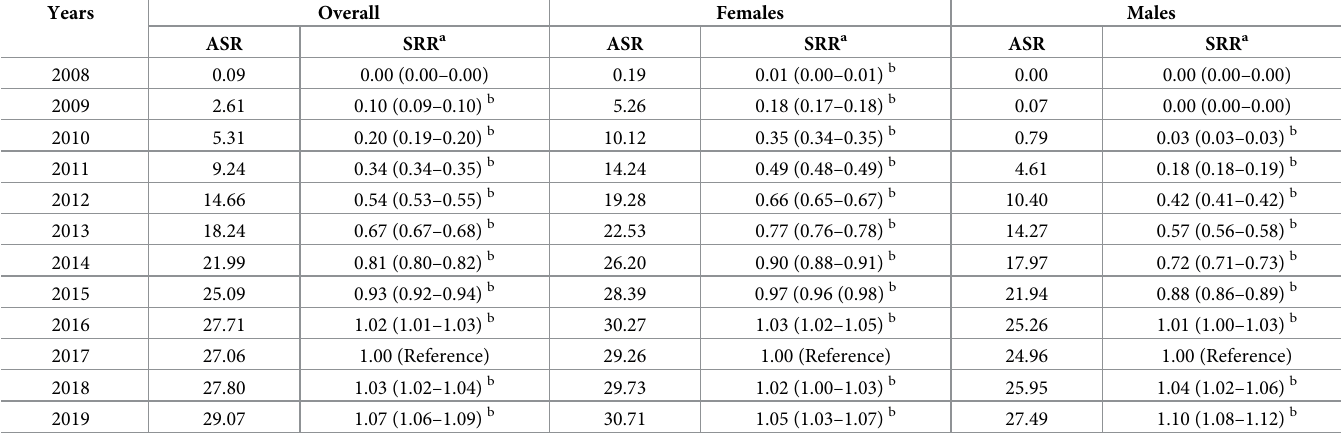
a The ratio of each year ASR to 2017 ASR as reference, with 95% confidence interval in parentheses. b P-value <